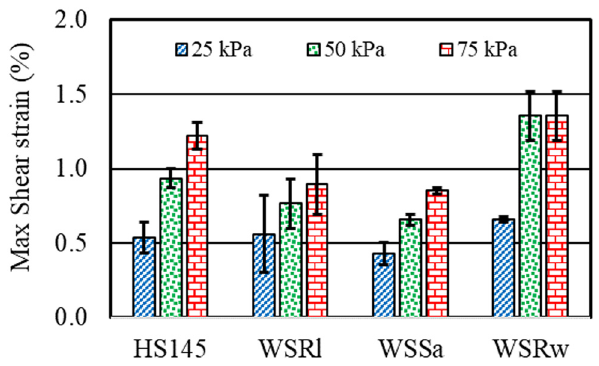
Figure 17: Maximum shear strain at each testing cycle of WMAs manufactured at 125°C.